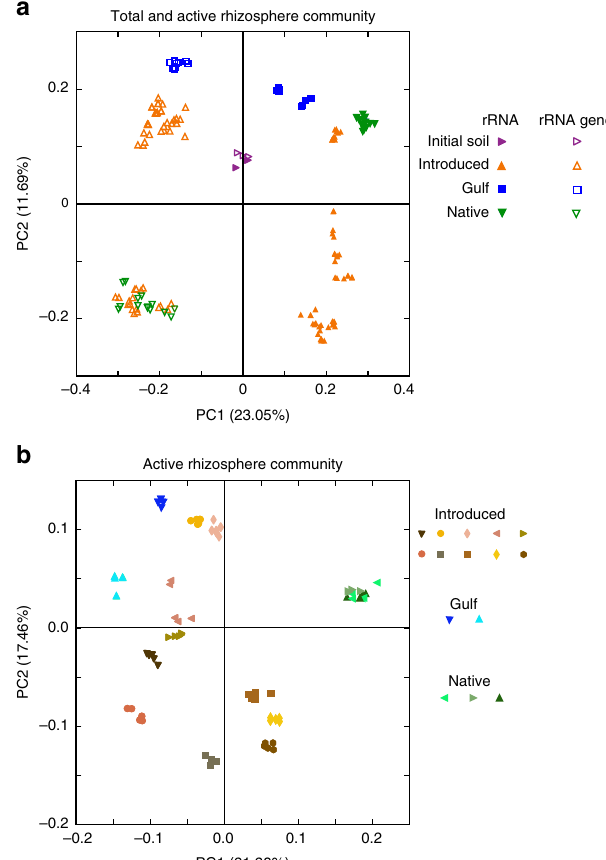
Fig. 3 Microbial community structure of different lineages of Phragmites australis grown in a common garden experiment. a Principal coordinates analysis of Bray – Curtis dissimilarity for the entire ( open symbols ) and active ( closed symbols ) microbial community, along with the pre-incubation community ( purple ). b Principal coordinates analysis of the Bray – Curtis dissimilarity values for just the active microbial community, indicating the importance of population (PERMANOVA, F 59,14 = 20.56, p < 0.001), and lineage ( F 71,2 = 19.79, p <